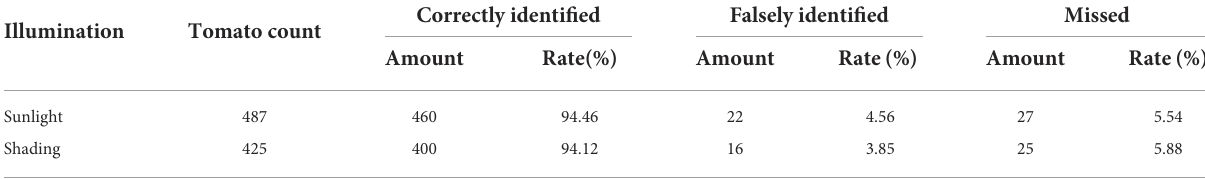
TABLE 4 Performance of the proposed TomatoDet under different lighting